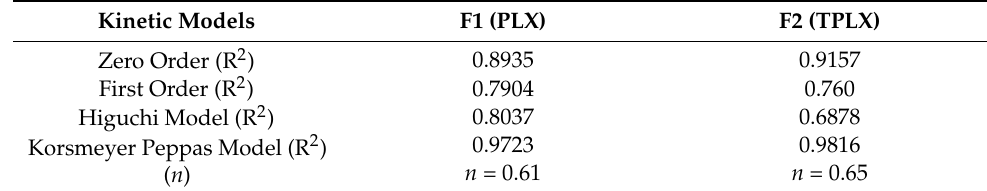
Table 7. Kinetic modeling of release data obtained from dissolution studies of F1 and F2.